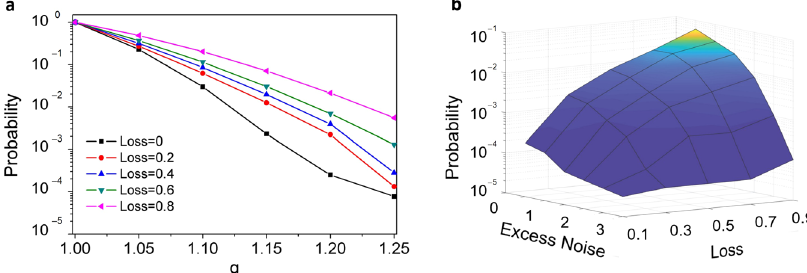
Fig. 5 The probabilities of the success. a The probability of success as a function of the g for different losses in a lossy channel. b The dependence of probability of success on loss and excess noise with a certain ampli fi cation gain g = 1.2 in a noisy channel.